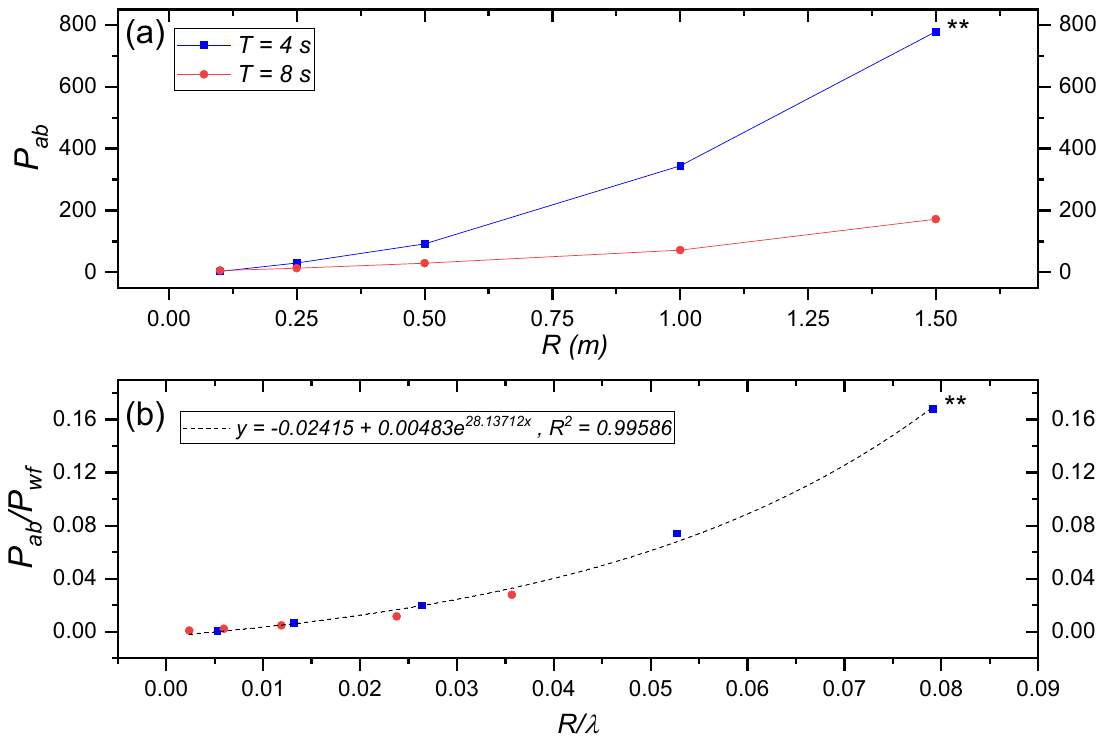
Figure 8. ( a ) Average power absorbed by the WEC at different radius sizes for both T = 4 s and T = 8 s wave periods. ( b ) Capture efficiency per buoy unit length for different values of the normalized buoy diameter (radius/wavelength) for both T = 4 s and T = 8 s wave periods. AR = 0.7, AD = 1, ID = 0.001, and OD = 1.5. ** OD = 2.0.